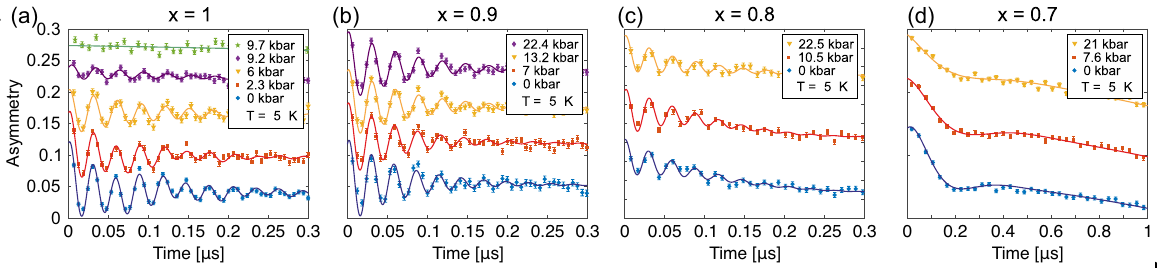
Figure 1. Zero field time spectra collected at selected pressures at T = 5 K for the Sr 1 − x Ca x Co 2 P 2 compounds: ( a ) x = 1 , ( b ) x = 0.9 , ( c ) x = 0.8 and ( d ) x = 0.7 . The solid lines represents fits using Eq. (1). Each spectra have been shifted vertically for clarity of